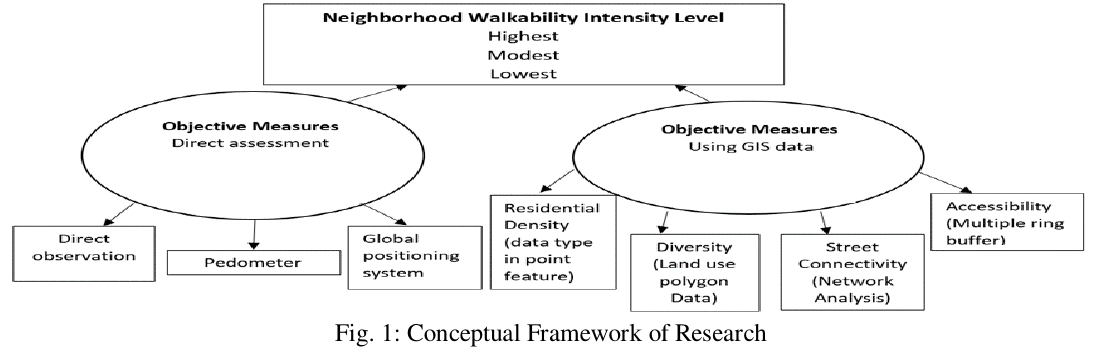
Fig. 1: Conceptual Framework of